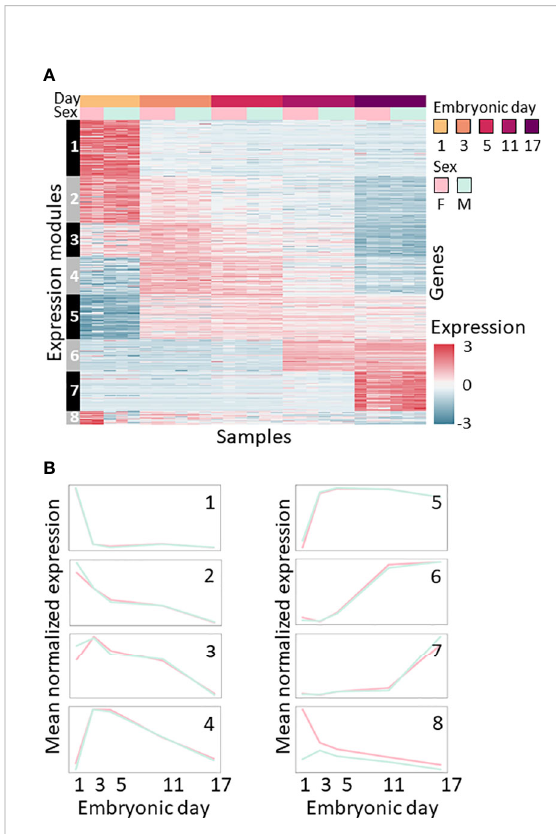
FIGURE 2 Expression patterns during the embryonic development of M . rosenbergii . (A) Expression level heatmap of the 2,000 most variable genes across all samples. Genes (rows) are sorted according to co-expression modules (marked on left). Samples (columns) are sorted by embryonic day (1 – 17) and sex, as the bar on the top shows. Colors represent standardized expression levels; see bar on the right. (B) Mean expression pro fi les of each of the eight modules of co-expressed genes identi fi ed during embryonic development of M. rosenbergii . Pro fi les are separated by sex, colored as in A, i.e., females in pink, and males in green. Figure 3A], with most of these genes (307 genes) being differentially expressed on embryonic day 1. As embryonic development progressed, there was a decrease in the number of genes differentially expressed between the sexes, i.e., 12, 10, 11, and 7 genes on embryonic days 3, 5, 11 and 17, respectively. Of the 329 genes that were differentially expressed between sexes, expression of 130 genes was higher in females (33 of those genes are known to be on the W chromosome and none on the Z chromosome) and expression of 199 genes was higher in males (24 of those genes are known to be on the Z chromosome and none on the W chromosome). One gene was differentially expressed on all embryonic days sampled, and eight genes were differentially expressed on more than one day, all upregulated in females. The validation study of cases of differentially expressed genes demonstrated similar patterns as found in the in-silico analyses results. The differential expressed